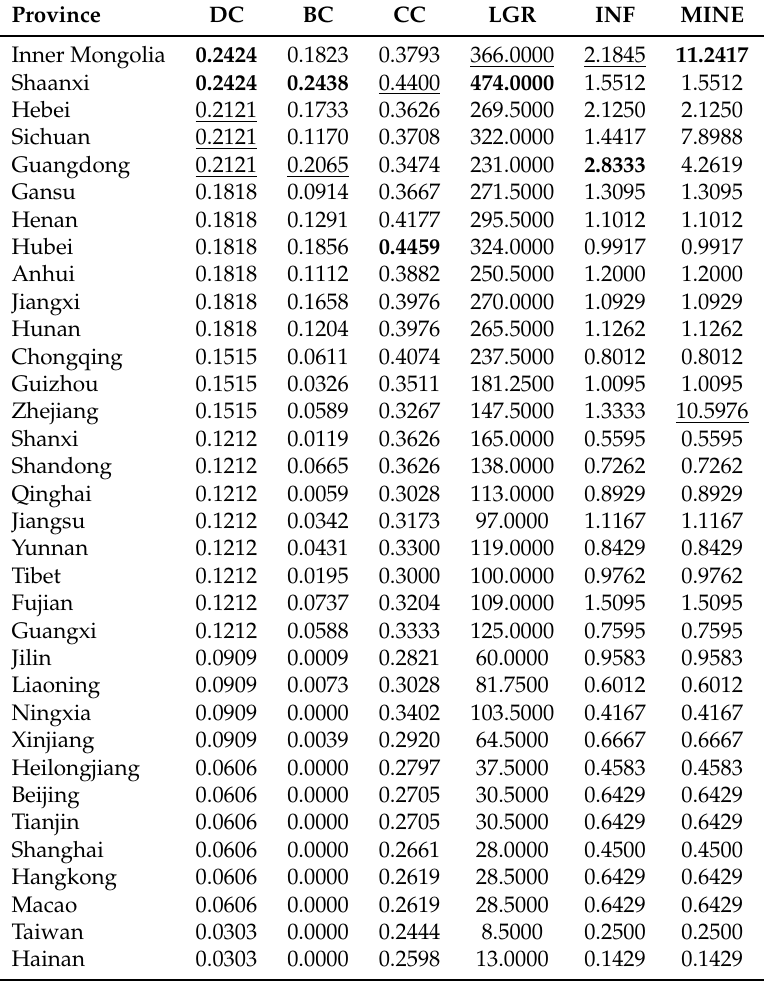
Table 5. Comparison of provinces of China, measured by DC, BC, CC, LGR, INF and